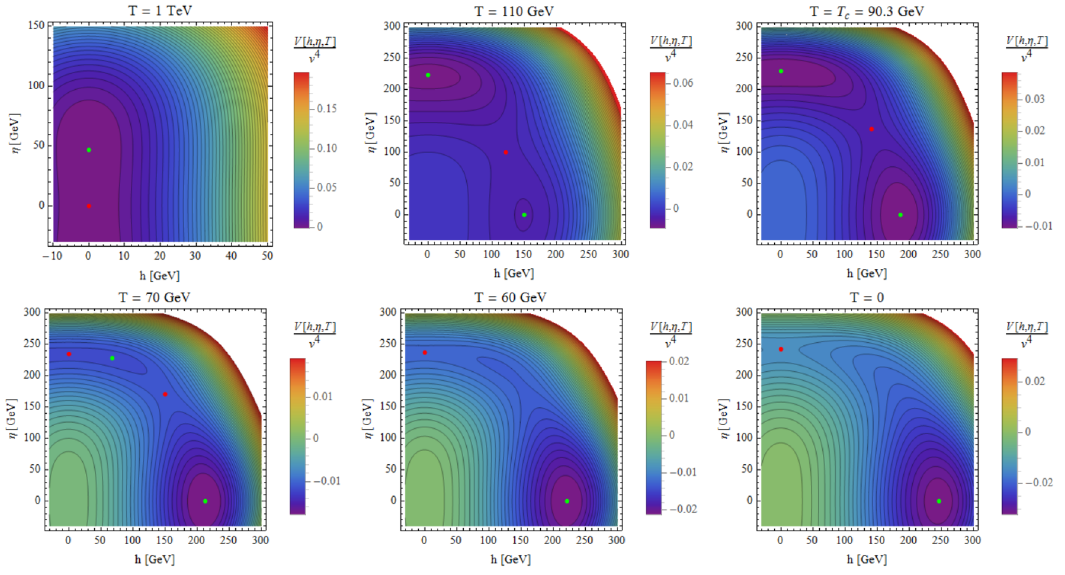
Figure 3 . Thermal evolution of the potential for a benchmark point with λ η = − 0 . 15 , λ hη = 0 . 1 , and m η = 75 GeV. The green dots denote local and global minima, whereas the red dots represent saddle points. The cutoff of the dimension-6 operator has been set to Λ = 1 . 5 TeV.